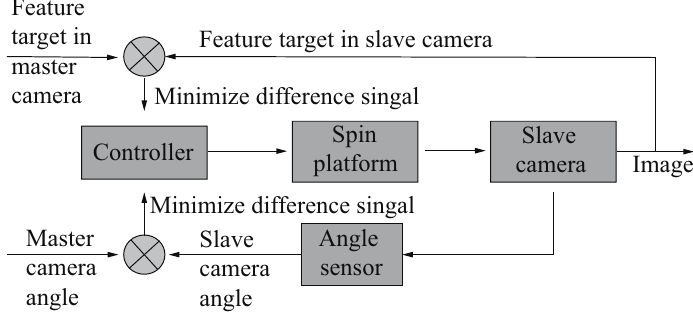
Figure 4. Double closed-loop feedback mechanism of the proposed